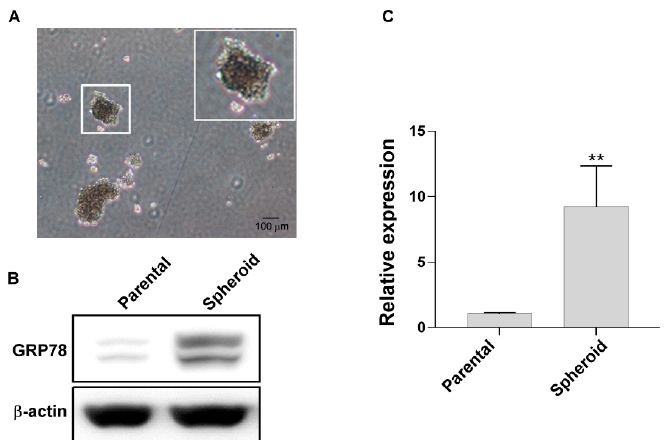
Figure 2. Glucose-regulated protein 78 (GRP78) was overexpressed in spheroid gastric cancer cells. ( A ) A representative picture demonstrating the MKN45 cells with the spheroid-forming ability. ( B ) Protein expression of GRP78 in parental and spheroid body-forming MKN45 cells. ( C ) Quantification of GRP78 expression in parental and spheroid body–forming MKN45 cells. Data are expressed as the mean ± standard error of mean; n ≥ 3 independent experiments, two-tailed Student’s t test: ** p < 0.01.